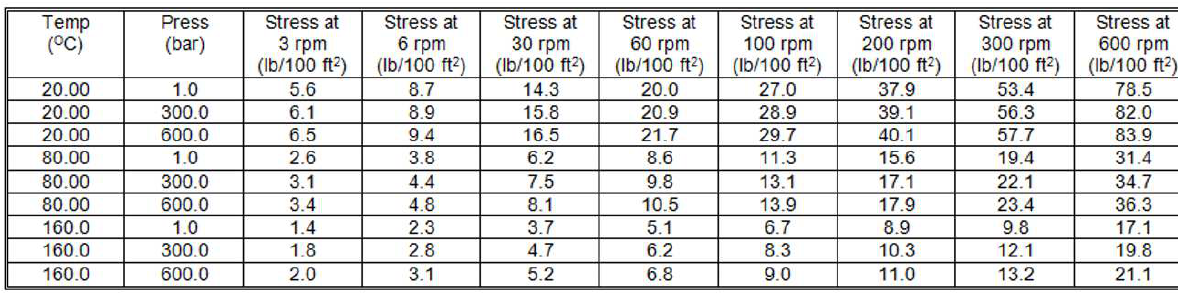
Table 2: Stress from Fann reading.